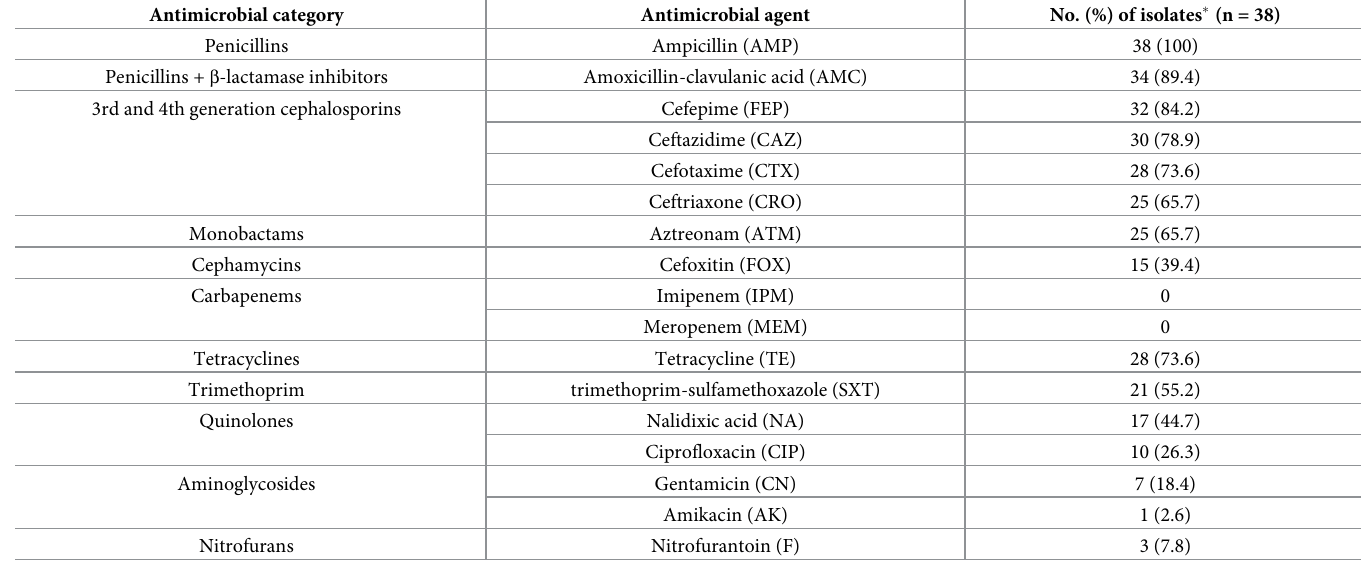
Table 6. Antimicrobial resistance of group B2 E . coli isolates from outpatients with UTI. Antimicrobial